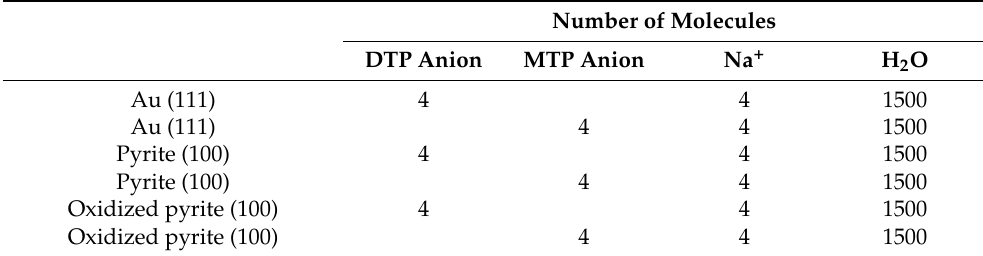
Table 1. The composition and number of molecules in each system.